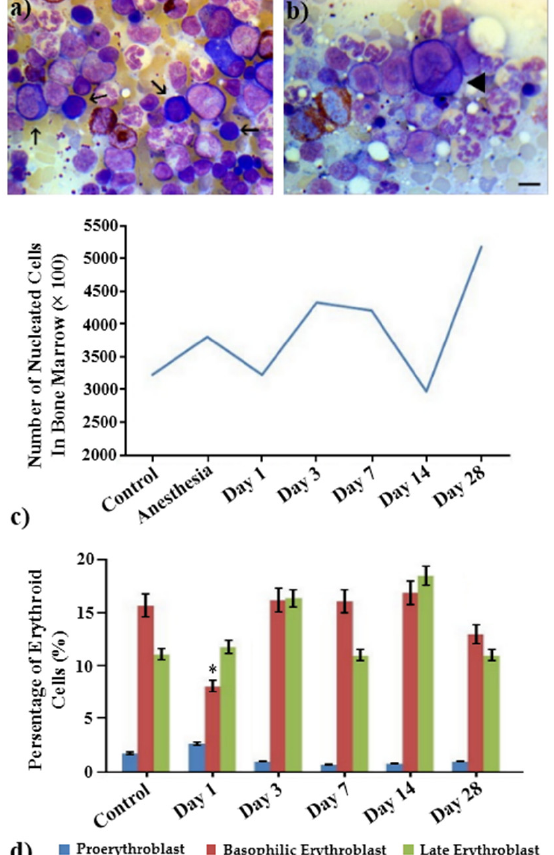
Figure 6. Erythroid cell populations in bone marrow samples of control and irradiated animals measured on the 1st, 3rd, 7th, 14th, and 28th days after irradiation with the laser-driven UPEB. ( a , b ) Representative images of bone marrow samples of control and irradiated animals (the arrows in ( a ) point to basophilic erythroblasts and the triangle in ( b ) points to the presence of proerythroblast). ( c ) Total number and ( d ) populations of nucleated erythroid cells in the bone marrow samples of control and irradiated animals. * p < 0.05 (compared to control). Scale bar is 10 μ m.